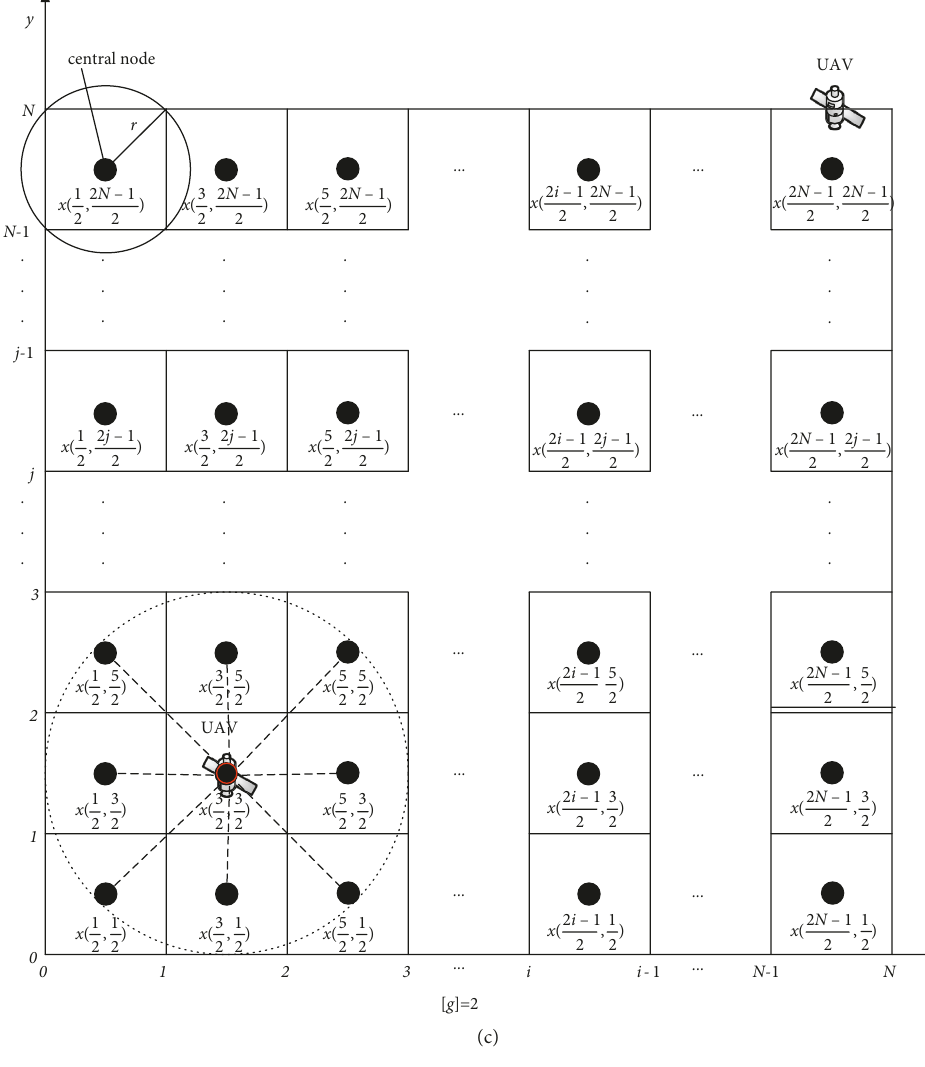
Figure 4: Path diagram of UAV with different parameters